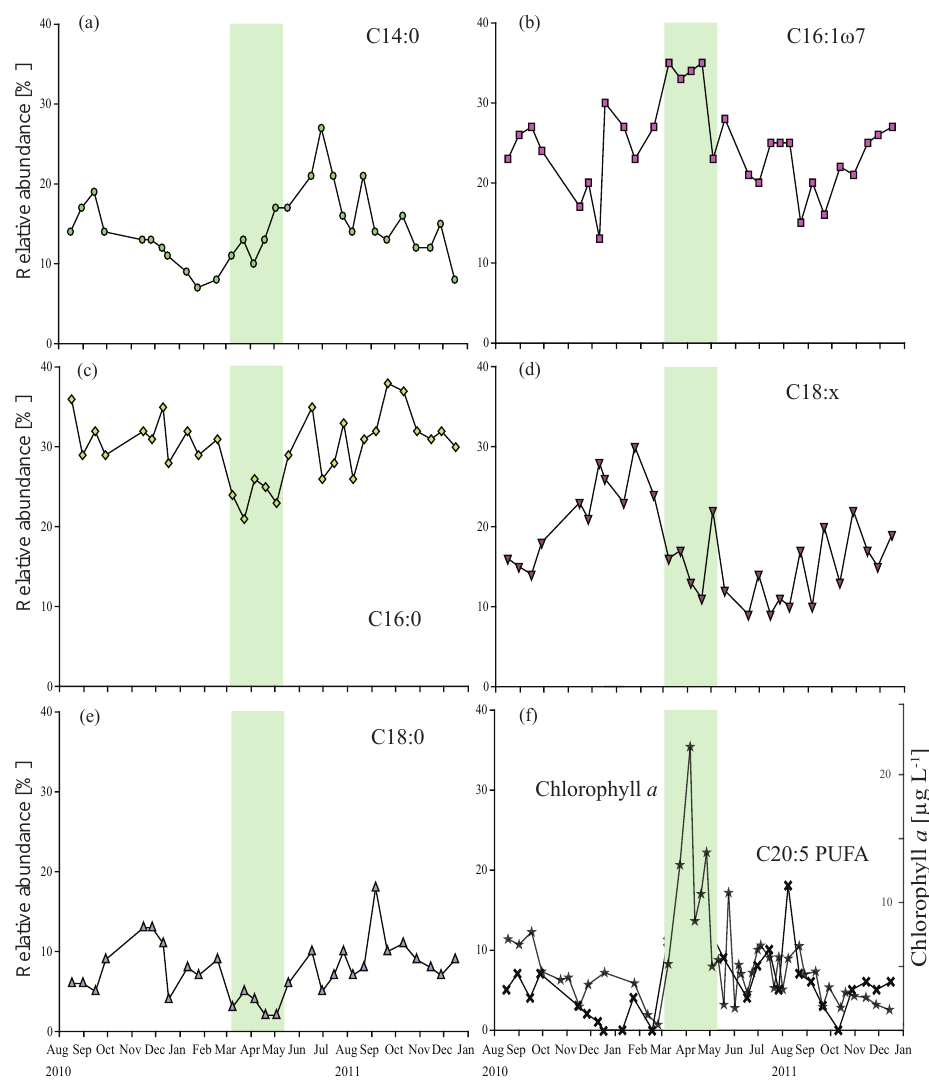
Figure 4. Relative abundance of fatty acids and chlorophyll a concentration in North Sea SPM. (a) n C14:0, (b) n C16:1, (c) n C16:0, (d) n C18:x, (e) n C18:0, (f) n C20:5 PUFA and chlorophyll a